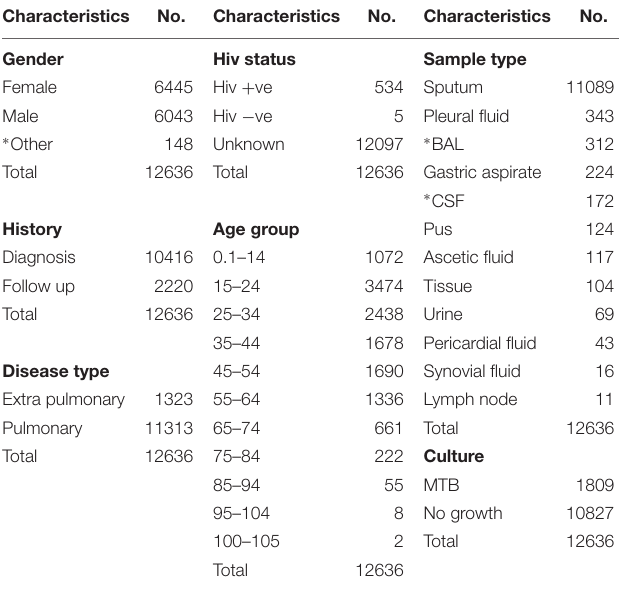
TABLE 1 | Characteristics of TB suspects/patients received from KPK TB units.